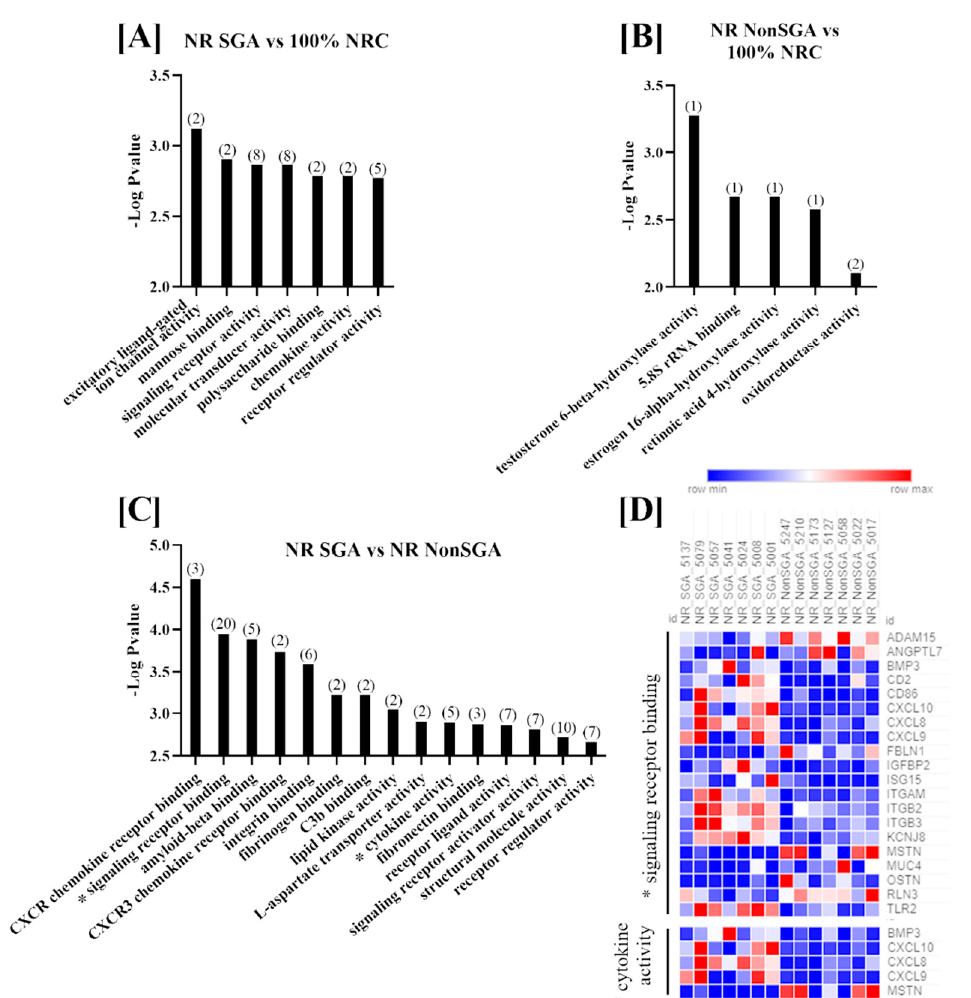
Figure 3. GO molecular function analyses of differentially expressed genes (DEGs) in placentomes at day 135 of pregnancy. Molecular functions differentially regulated in NR SGA compared to 100% NRC placentomes ( A ), NR NonSGA compared to 100% NRC placentomes ( B ), and NR SGA compared to NR NonSGA placentomes ( C ), with a heat map of genes involved in “signaling receptor binding” and “cytokine activity” ( D ). The heat map corresponds to one sample for each column and one gene for each row. All depicted GO molecular functions were significant at FDR < 0.05. Numbers in parentheses indicate the number of differentially expressed genes involved in the function.